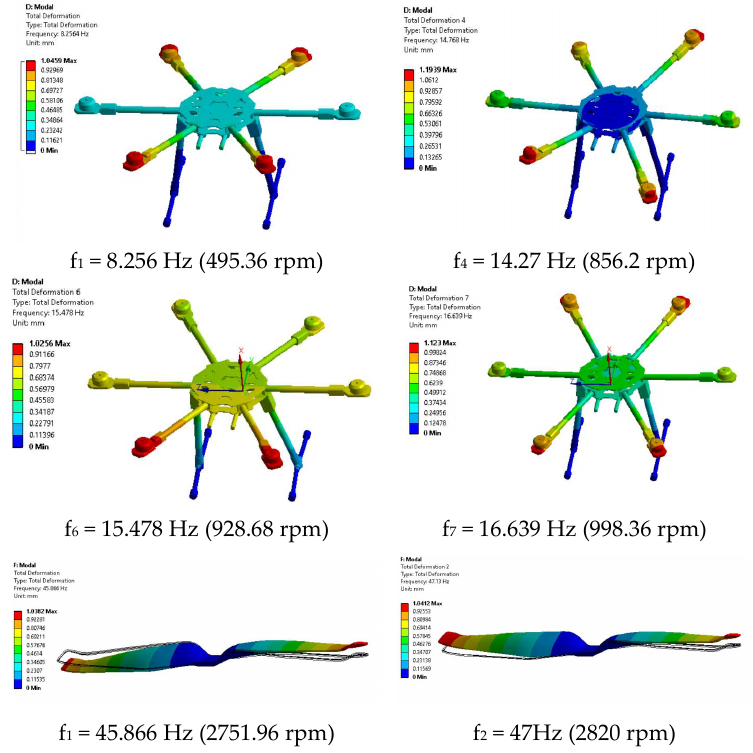
Figure 42. Mode shapes of the structural components and of the propeller.